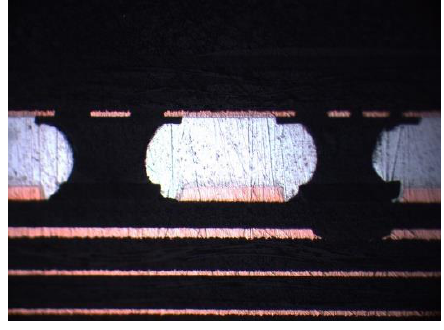
Figure 7. Intact solder joint observed under a metallurgical microscope. Appl. Sci. 2020 , 10 , 1951